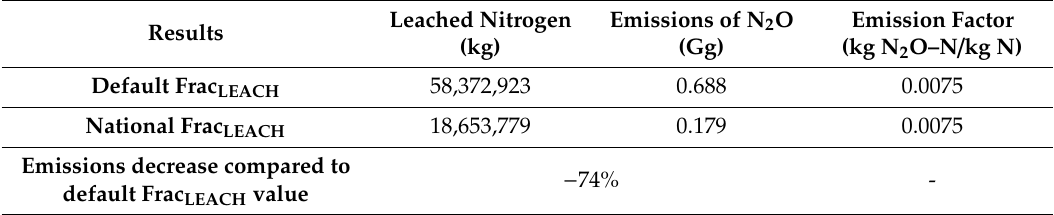
Table 5. Total leached nitrogen, emission factor, and resulting N 2 O emissions from leaching in 2017.